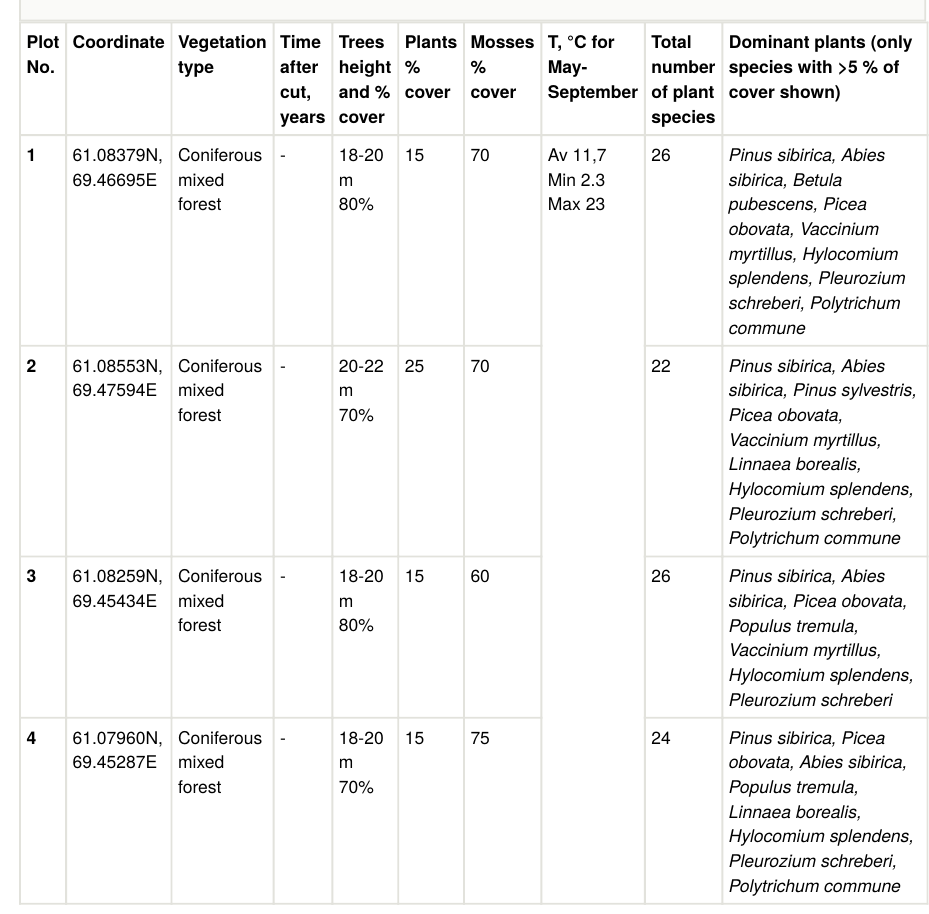
Characteristics of permanent plots of macromycetes observations in di ff erent forest types in vicinities of Khanty-Mansiysk, West Plot Coordinate Vegetation No. type